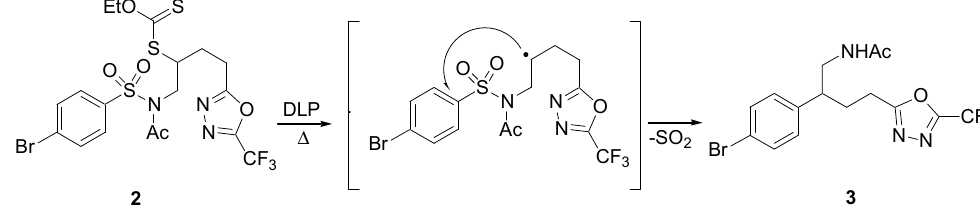
Scheme 3. Example of Smiles rearrangement starting from xanthate.